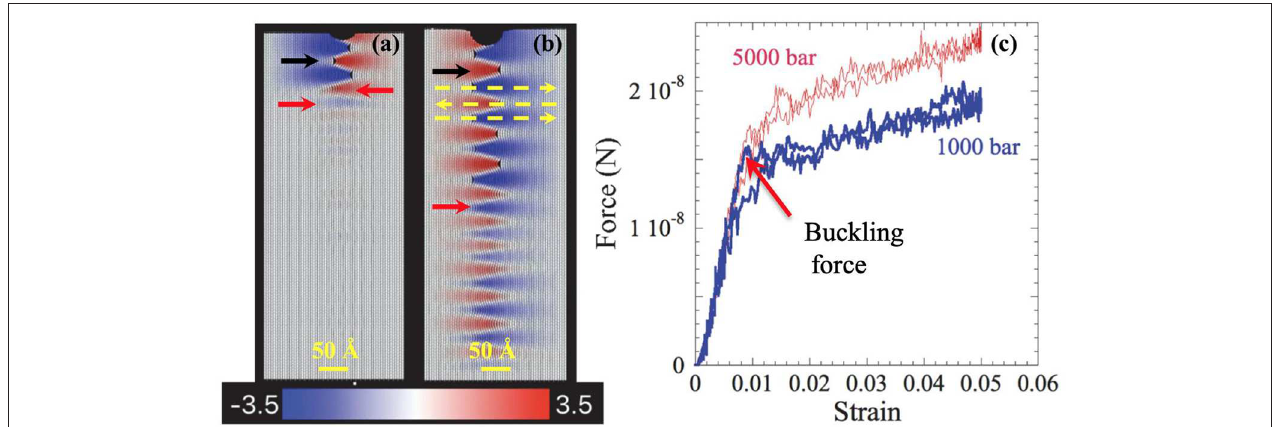
FIGURE 9 | (a) Molecular dynamics, MD, simulation of indenting graphite layers edge-on at the nucleation of the RBs. Color scale in (a) quantifies atomic motion along the z axis, in Å, to the right (blue) or left (red). (b) same as (a) , but at maximum penetration. (c) MD load vs. strain curves. Point at which the slope of the force/strain curves changes coincides with nucleation of ripplocation boundaries, RBs. Process is fully reversible (Barsoum et al., 2019). Yellow arrows denote RBs of opposite signs. Black arrows point to delaminations. Horizontal red arrows point to regions where the deformation in accommodated without delaminations. Black arrows point to